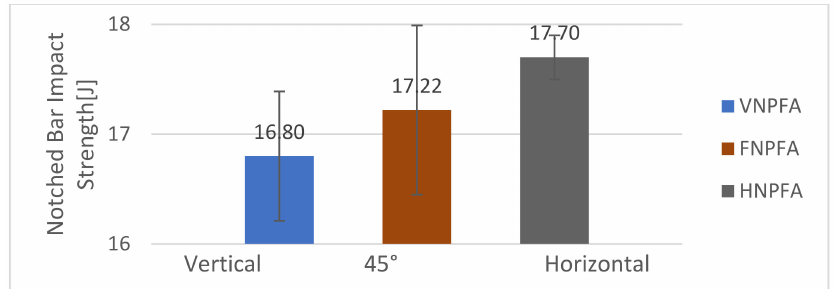
Figure 11. Notched bar impact strength for vertical, 45 ◦ , and horizontal furnace-annealed